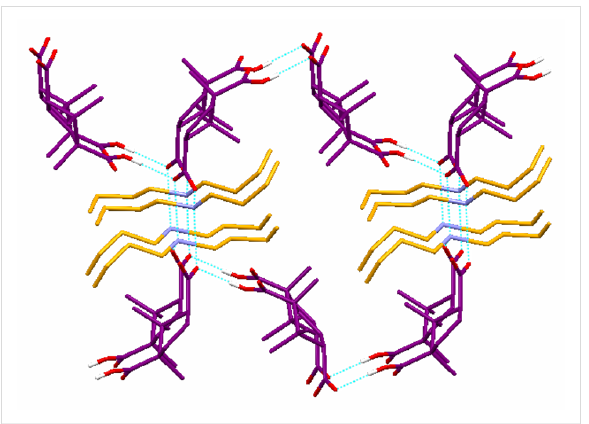
Figure 5: Crystal structure illustration of DBUAMC 3 ; 3-D hydrogen bonded network; only one part of the disordered ammonium cation and hydrogen atom associated with carboxylic moiety are shown for